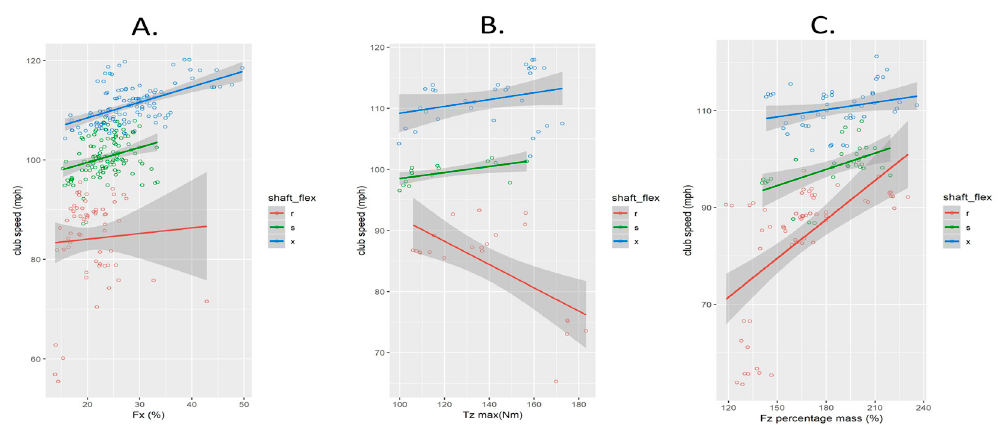
Figure 4. Above, driver-only shots are plotted. Subcategorizing each player into their primary force mechanism showing ( A ) sliders, ( B ) twisters ( C ) jumpers and plotting this factor against clubhead